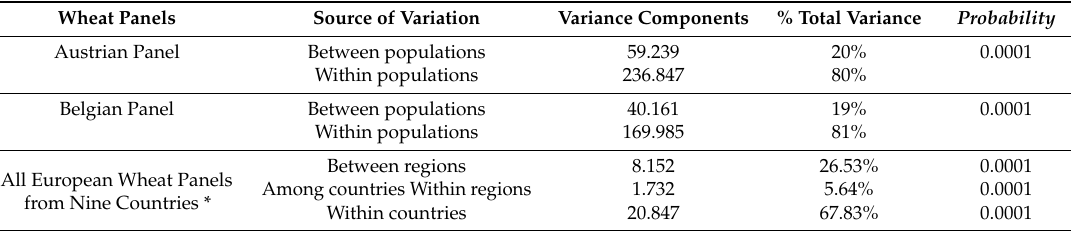
Table 3. Analysis of molecular variance (AMOVA) of wheat panels from Austria (between and within populations), Belgium (between and within populations), and all nine European countries (between regions, among countries within regions, within regions).